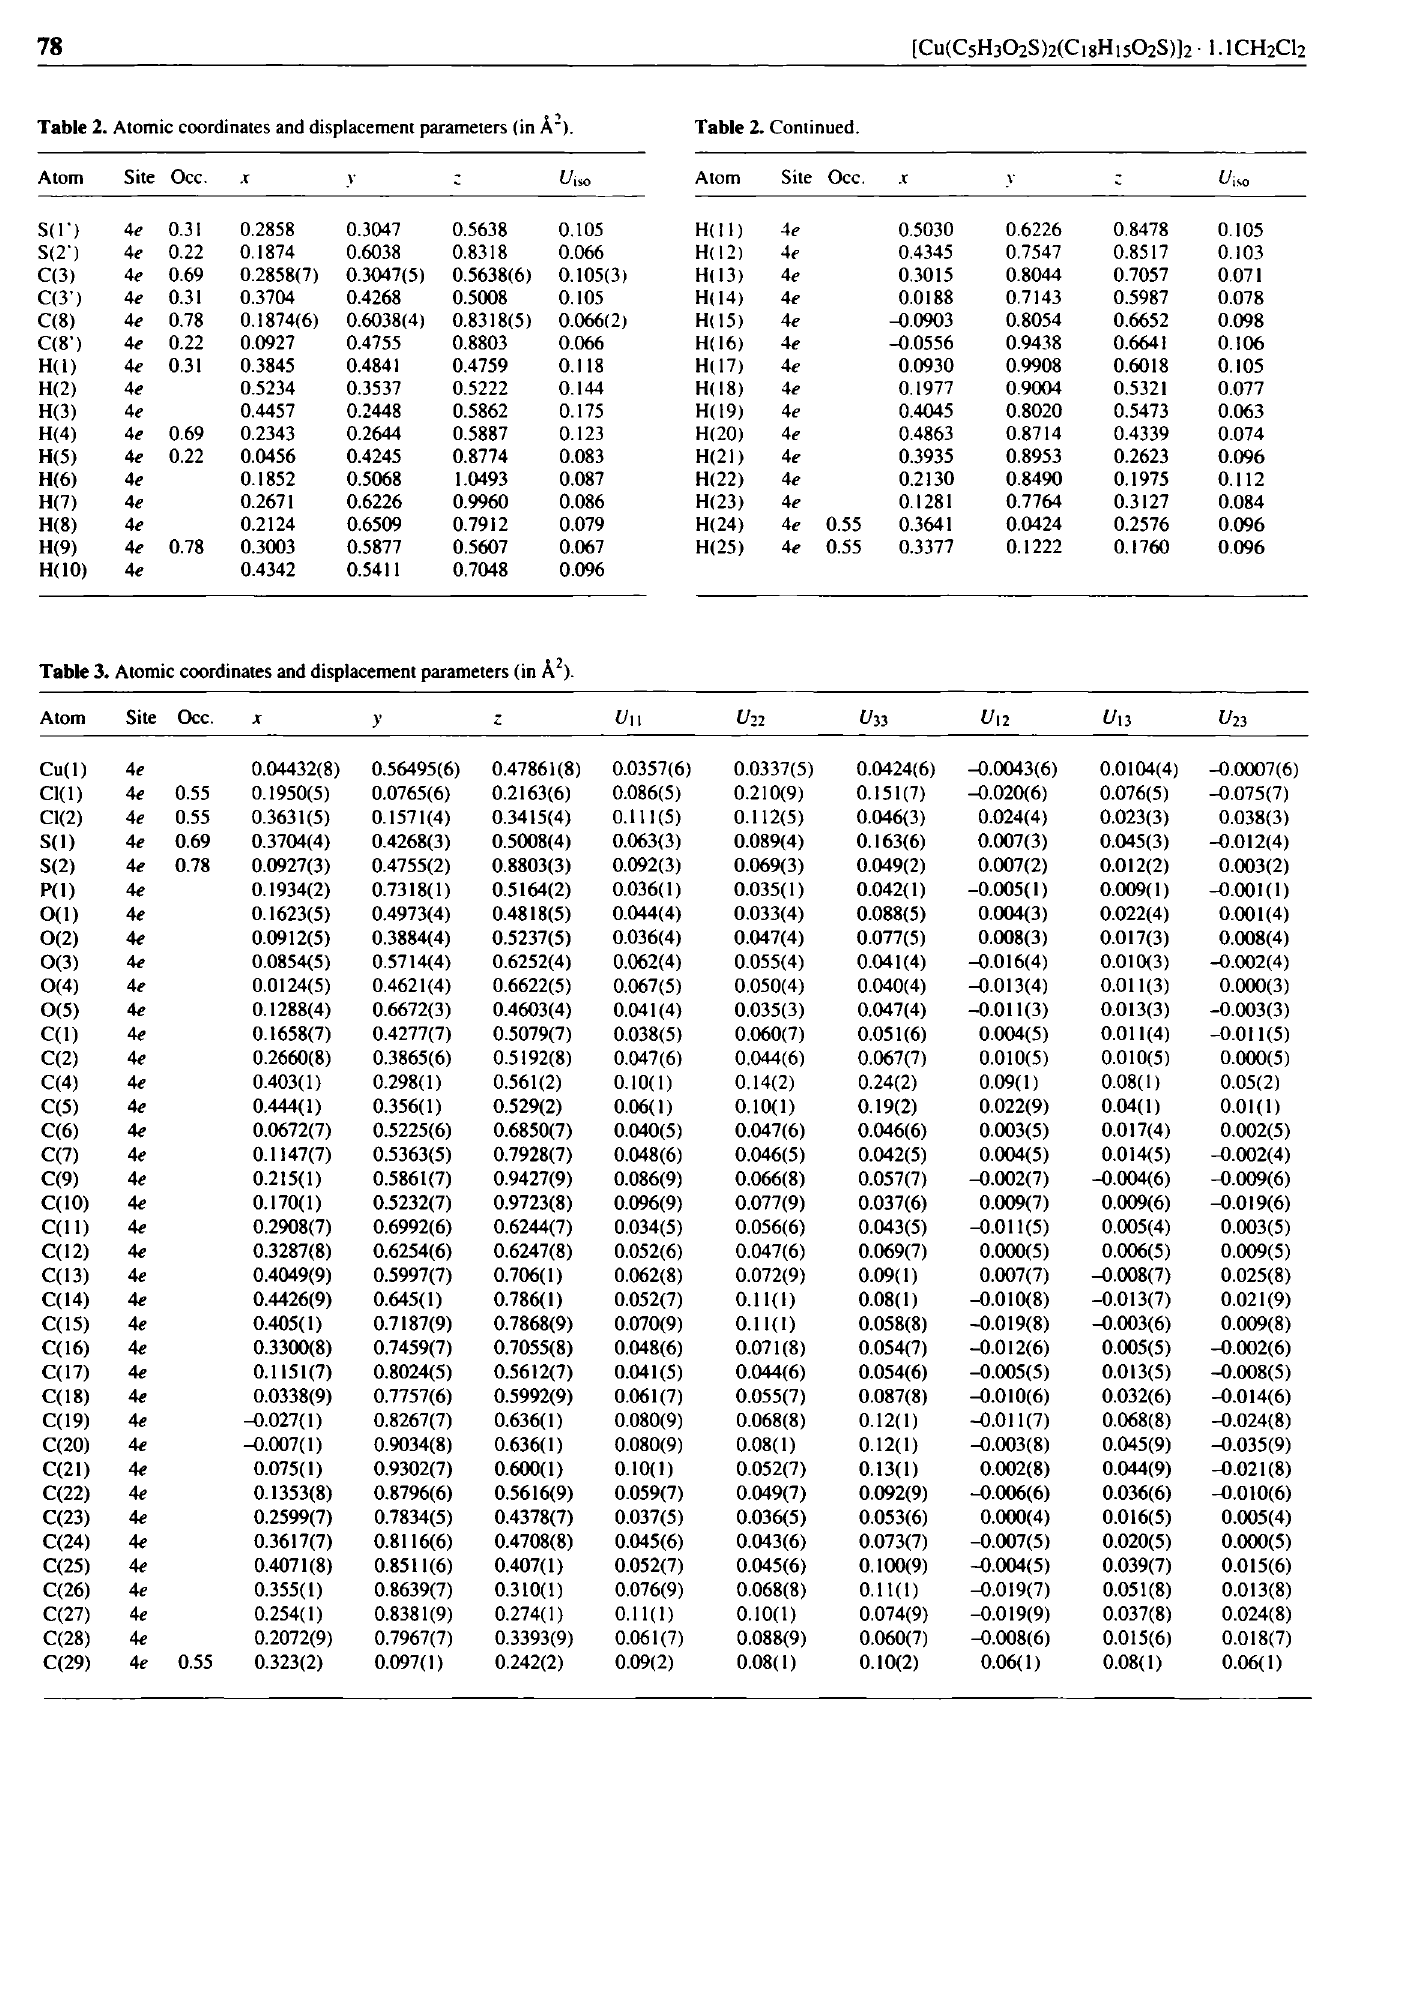
Table 3. Atomic coordinates and displacement parameters (in Ä 2